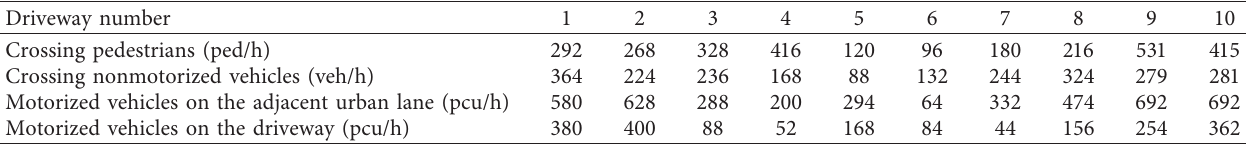
Figure 17: Wanda Plaza driveways. (a) Driveway 1. (b) Driveway 2. (c) Driveway 3. (d) Driveway 4. (e) Driveway 5. (f) Driveway 6. (g) Driveway 7. (h) Driveway 8. (i) Driveways 9 and 10. Table 4: Traffic volume from 6:00 pm to 7:00 pm on June 29,